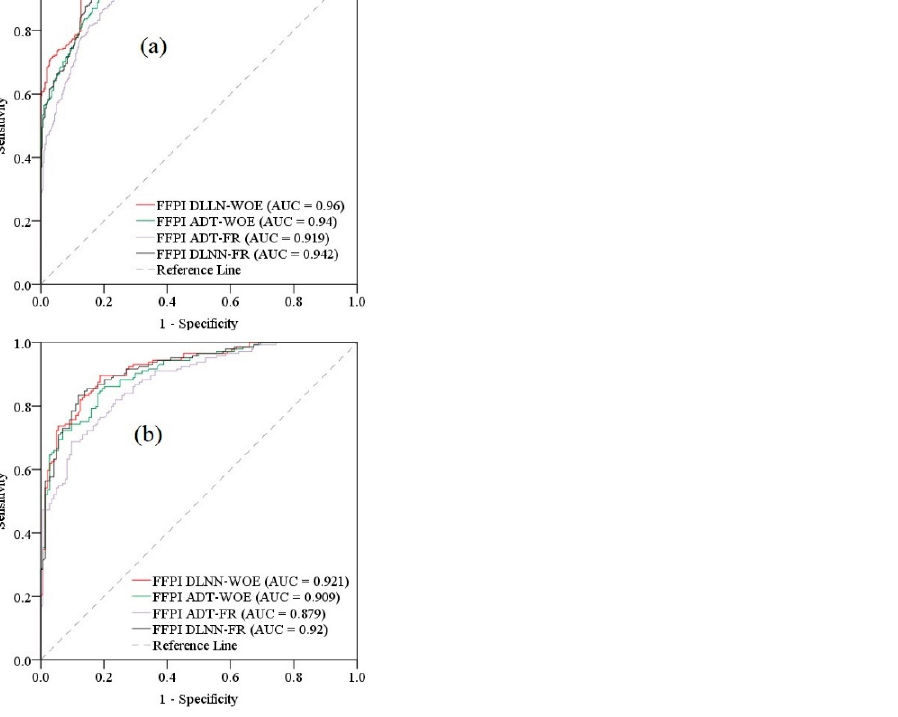
Figure 13. Receiver Operating Characteristic (ROC) curve ( a ). Success Rate; ( b ). Prediction Rate).